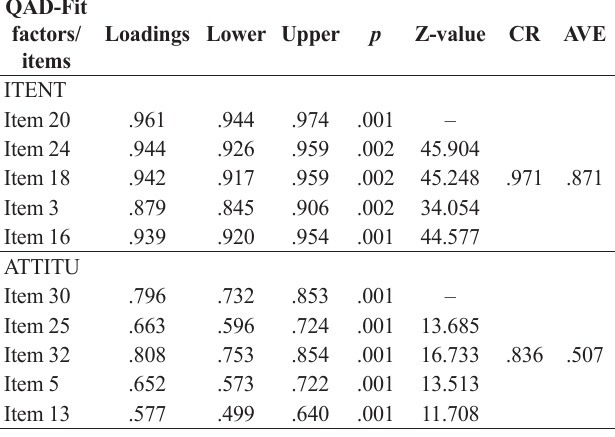
Table 2. QAD-Fit Re-specified first-Order Model-Factor Loading, Z-values, Composite Reliability (CR) and Average Variance Extracted (AVE).